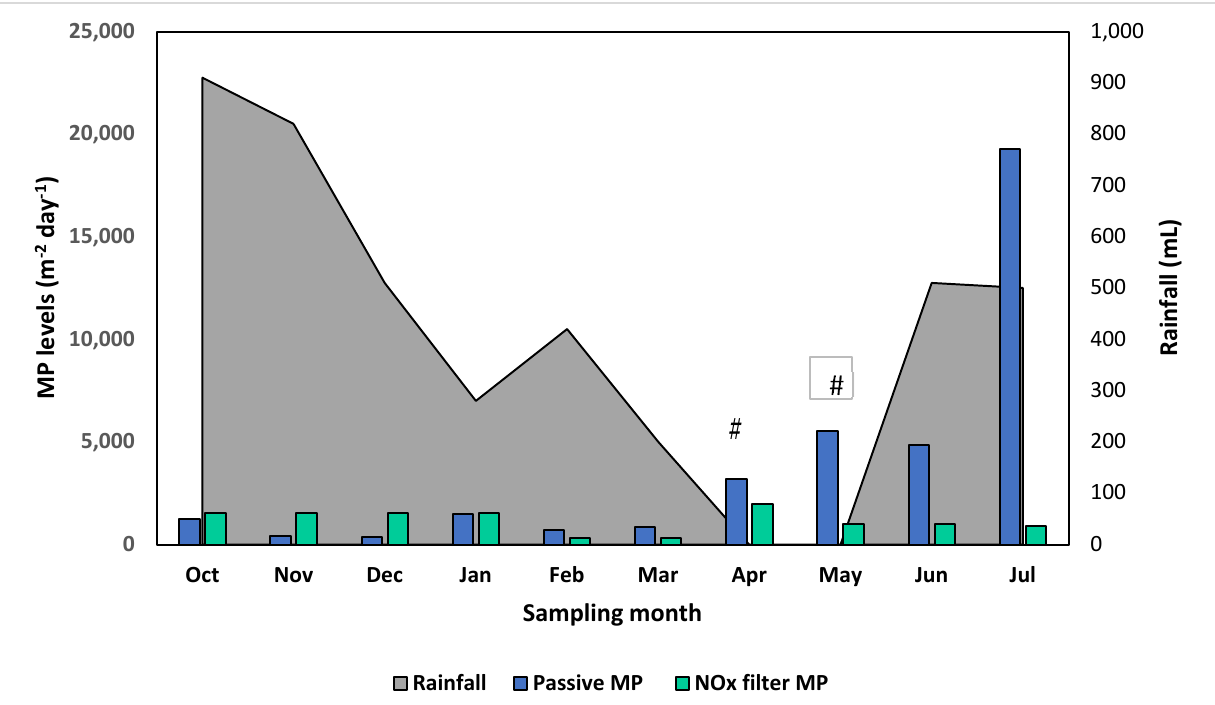
Figure 3. The total number of MPs identified, within the 10 ‐ month sampling period, at the roadside sampling site (‘A63’) using both NOx inlet filter (October/November, December/January, February/March, May/June pooled data onto one filter) and previously published rain sampler approaches. The total rainfall during each varied ‐ week sampling period is presented alongside. # Symbol indicates periods in which an official COVID ‐ 19 lockdown was issued.